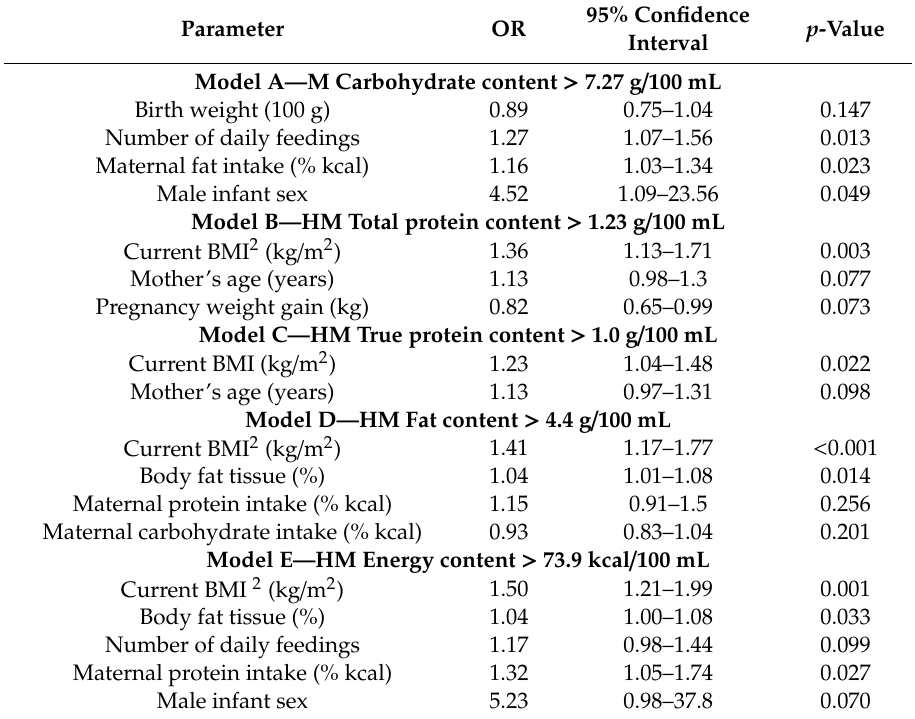
Table 5. Multiple logistic regression models explaining the relationship between maternal and infant factors and HM